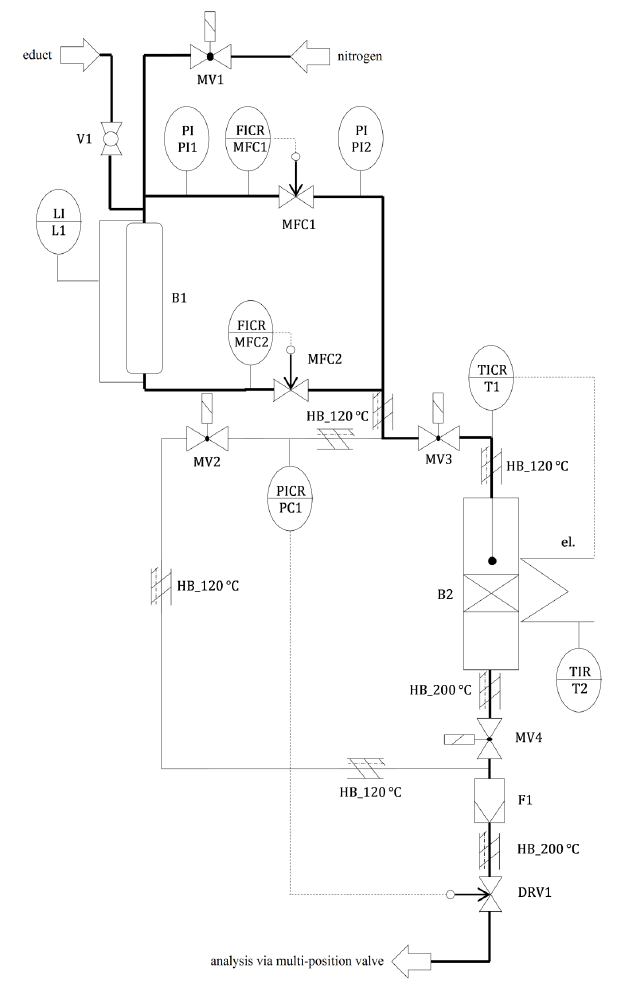
Figure A4. Flow diagram of a reactor line of the multiple reactor plant used. Catalysts 2020 , 10 , x FOR PEER REVIEW